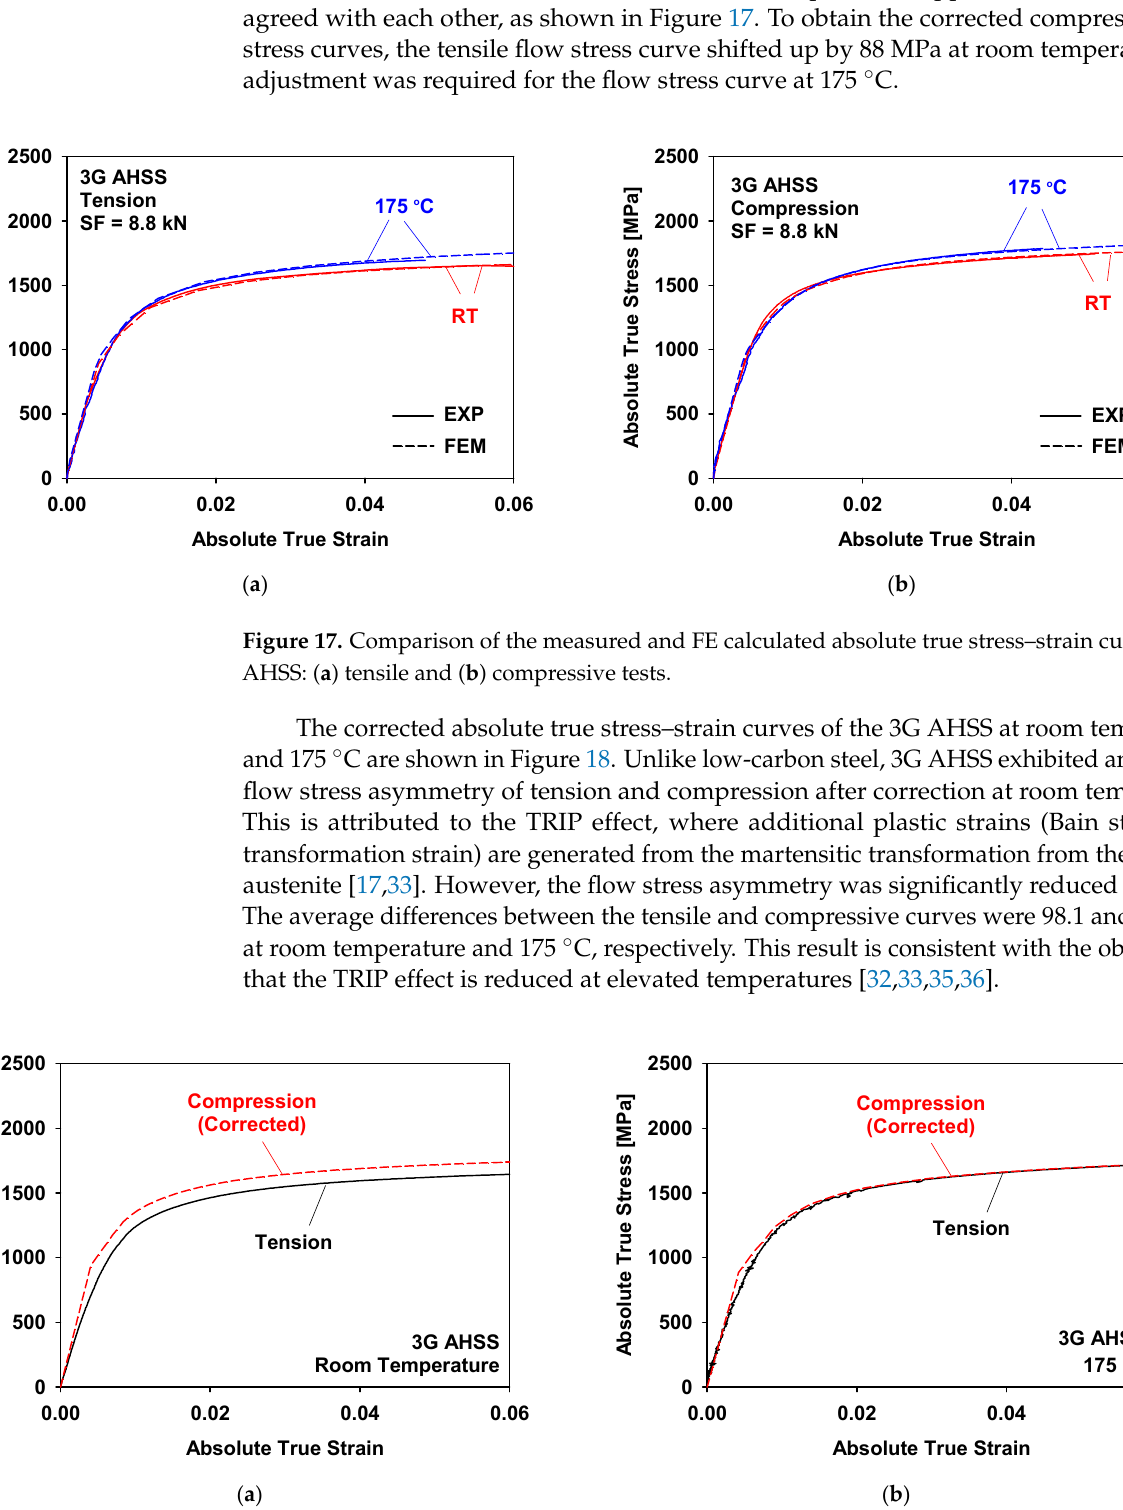
Figure 18. Corrected absolute true stress ‐ strain curves of 3G AHSS at ( a ) room temperature, and ( b ) 175 °C for tension and compression.